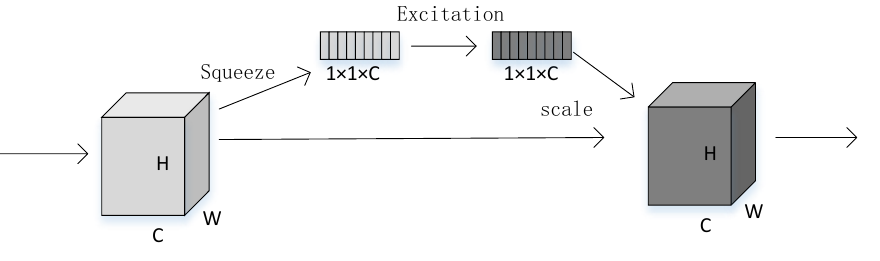
Figure 5. Structure of the SENet module.